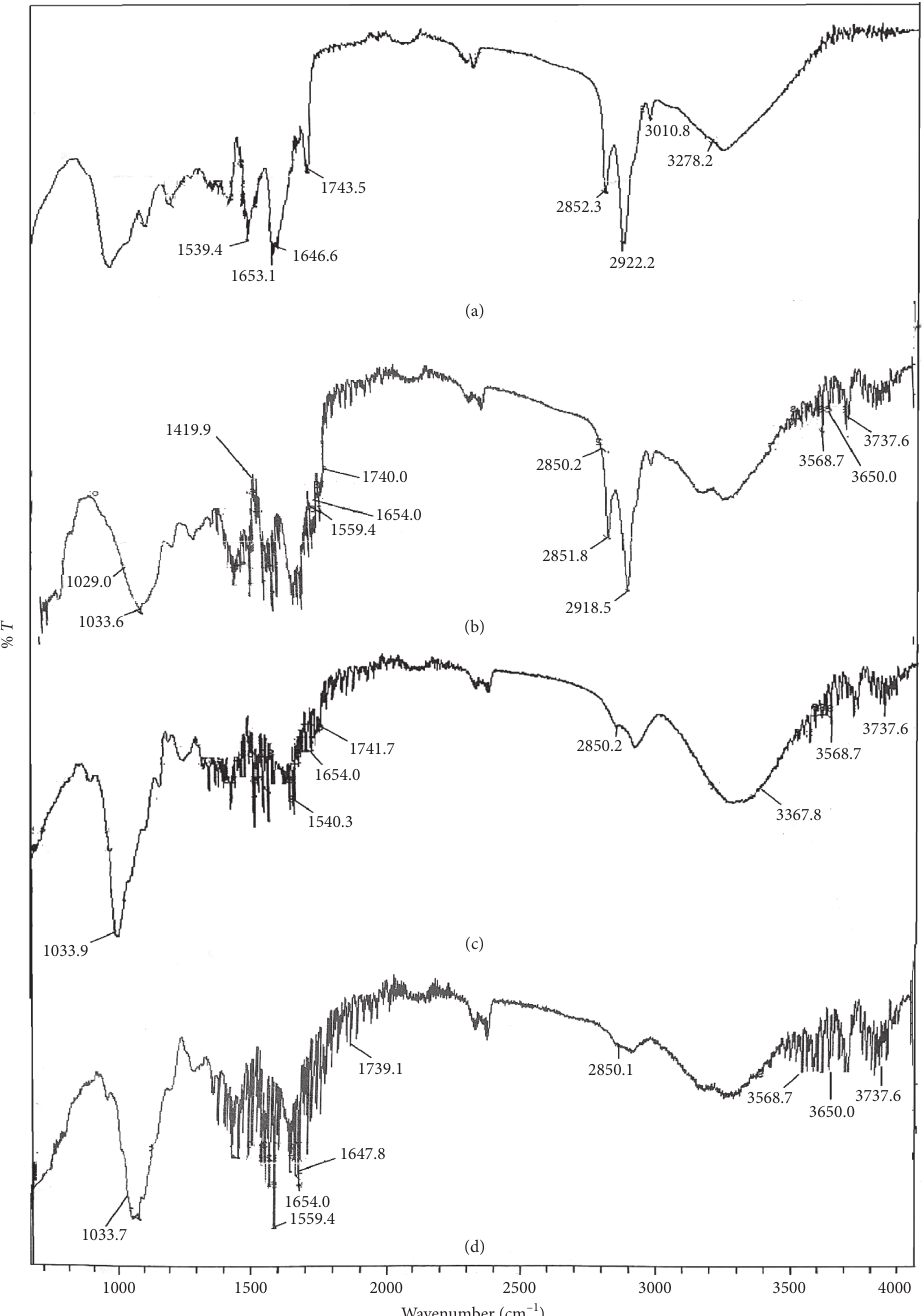
Figure 2: FT-IR spectra of (a) Ha with BG, (b) Ha-Ta with BG, (c) Cc with BG, and (d) Cc-Ta with